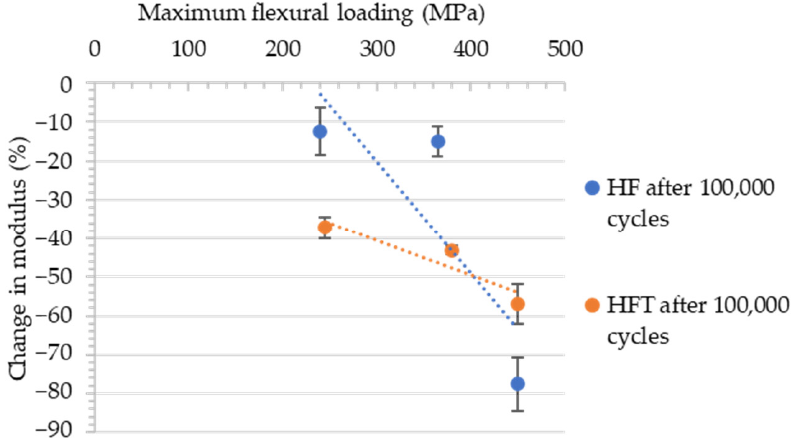
Figure 20. Cyclic loading of hybrid and veil toughened hybrid with PA 6,6 for 100,000 cycles at 50, 70, and 90% maximum flexural strength. Samples individual loading for HF is 240, 365, and 450 MPA and HFT loaded at 245, 380, and 450 MPa.